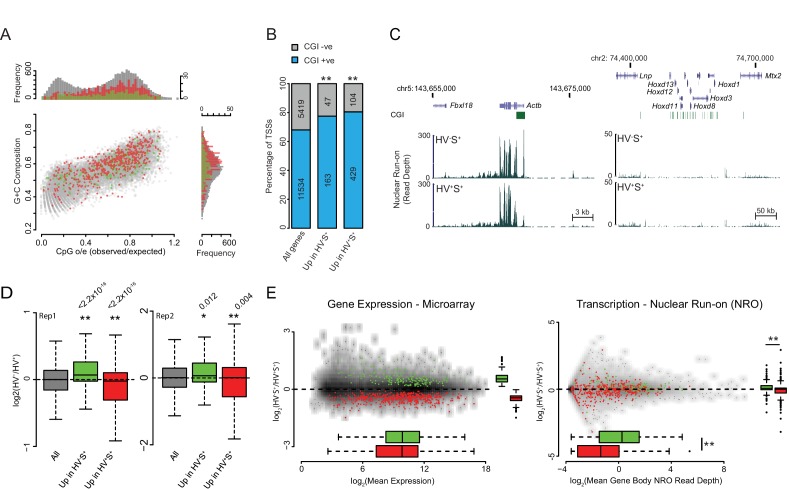
Validation and characterisation of priming genes.(A) Scatter plot comparing CpG observed/expected (o/e) ratio vs G+C composition at the TSS (+/- 500bp) for all genes (grey) and for those upregulated in the HV-S+ (green) and HV+S+ (red) populations of ESCs. (B) Barplot showing the percentage of TSSs that overlap a CGI for all genes and for those upregulated in the HV-S+ and HV+S+ populations of ESCs. Significant over-representation with p values of < 0.01 as determined using a Fisher’s test are indicated**. (C) Example GRO-seq profiles (normalized read depth) at the ‘control’ loci Actb (constitutively expressed) and Hoxd (canonical Polycomb target and silent in ESCs). Profiles were generated using the UCSC genome browser with coordinates given for mm9. (D) Boxplots depicting the two GRO-seq replicates (independently grown ES cultures) which were combined to produce the data shown in Figure 1E–G. The boxplots show the log2 ratio of GRO-seq signal between HV-S+ and HV+S+ ESC populations for all genes (grey), genes upregulated in HV-S+ (green) and genes upregulated in HV+S+ (red). Two-sample permutation tests (oneway test) were used to compare the GRO-seq signal at priming vs all genes. p values of < 0.01 are indicated** and noted above the plot. (E) MA plots depicting steady-state mRNA levels as measured by Microarray (left panel) and nascent RNA levels as measured by GRO-seq (right panel) for genes up in HV-S+ (green) and HV+S+ (red). Significant results with a p value < 0.01 as determined by a Wilcoxon Rank Sum Test (comparing GROseq read depth) and a two-sample permutation test (comparing Log2 ratio values) are indicated**.